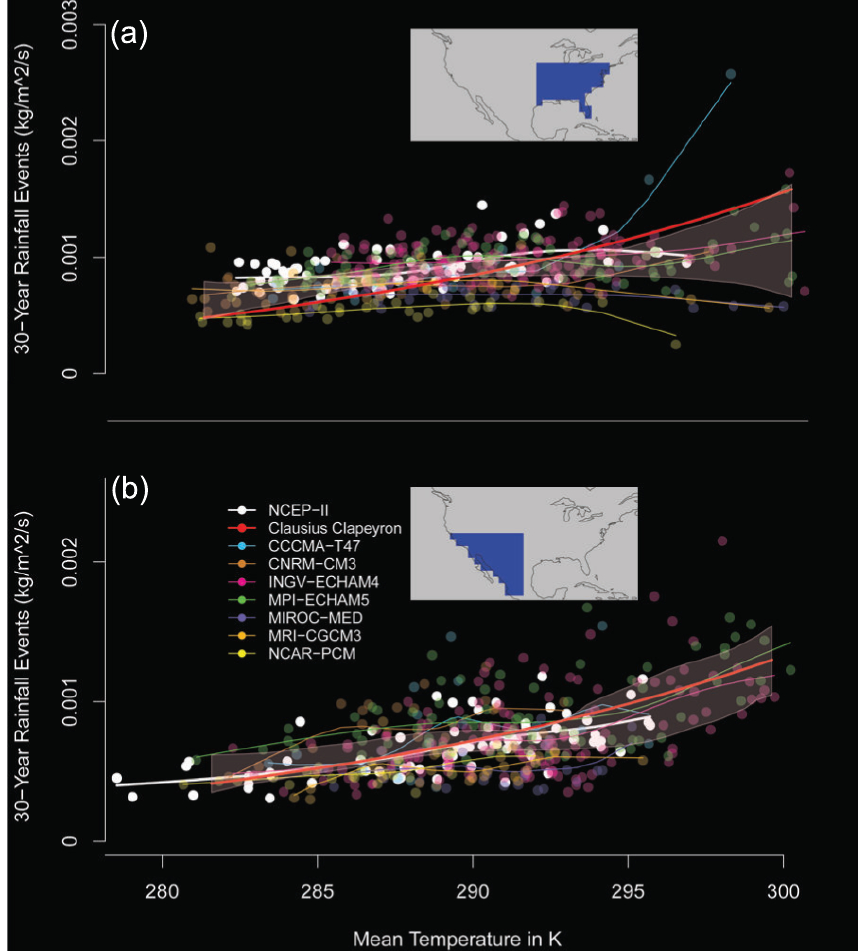
Figure 5. Uncertainty quantification adds to the big data challenge. Multimodel ensembles have been used to quantify uncertainty in the structural representation of climate physics; their performance has been evaluated by investigating skills in reproducing historical behavior (skills) and multimodel agreement (convergence) in the future. Here we investigate the uncertainty in precipitation extremes and explore whether physically based relations, like the temperature-dependence of precipitation extremes through the saturation vapor pressure (known as the Clausius–Clapeyron, or CC, relation), may help further inform uncertainty assessments and skill-based model selection. For the (a) southeastern and (b) southwestern US, a 7-member CMIP3 model ensemble is used for the analysis, with NCEP2 used as a baseline model and the theoretical CC curve shown for comparison. Every point from each model represents a 20 year mean temperature (1980– 1999) on the x axis and a 30 year daily rainfall return value, i.e., a daily rainfall intensity that on average occurs or is exceeded only once in 30 years (1980–1999, y axis) with nonlinear regressions fit to each data set and uncertainty bounds computed using a bootstrap-based resampling procedure. The value of using the multivariate physically based CC relation in uncertainty quantification is suggested, particularly for extremes (specifically, heavy rainfall) where covariate relations (specifically, temperature-dependence) are known from process physics (e.g.,